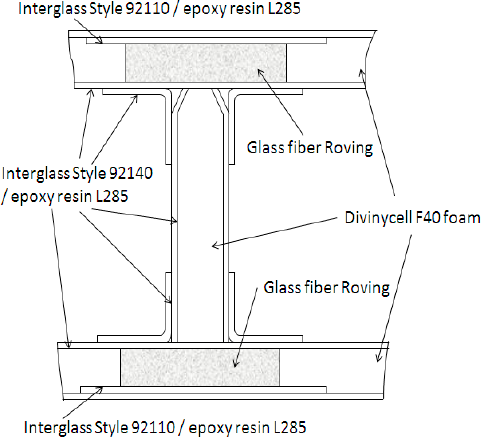
Figure 1. Presentation of the materials from which the composite spar is manufactured [35].